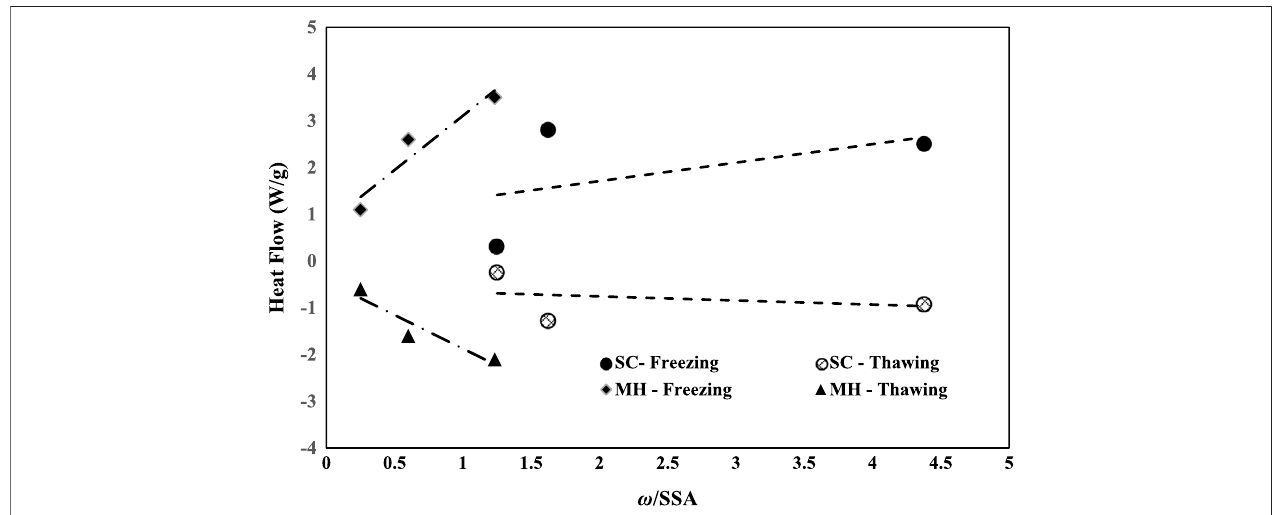
FIGURE 10 | In fl uence of speci fi c surface area on freezing – thawing characteristics of plastic and non-plastic silts. In fl uence of freeze – thaw cycles on thermal conductivity of soils.